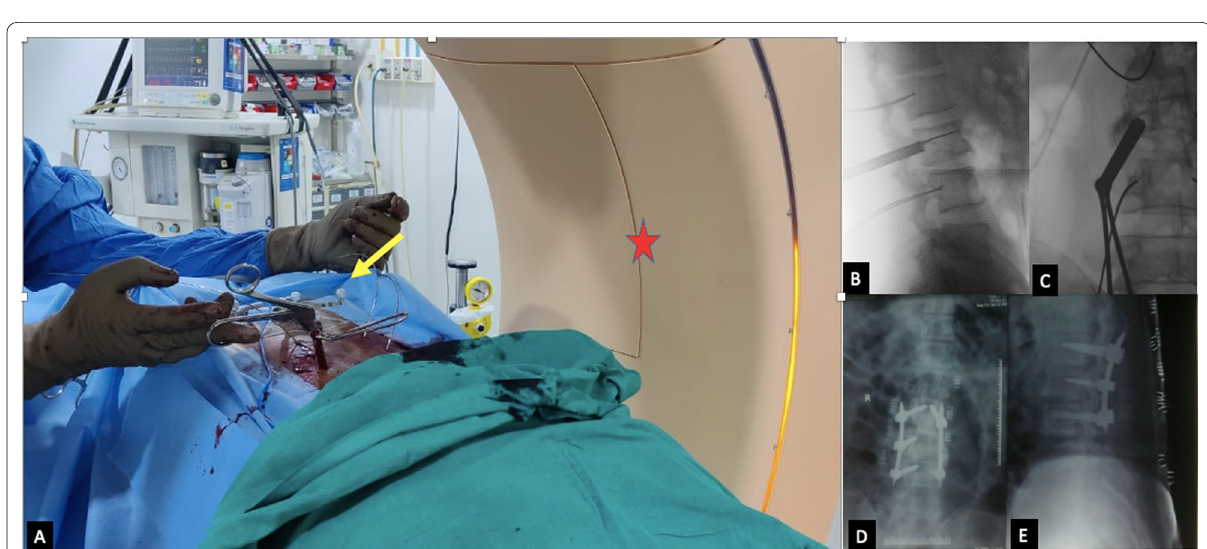
pushed in before withdrawing and a stitch was taken. Per-